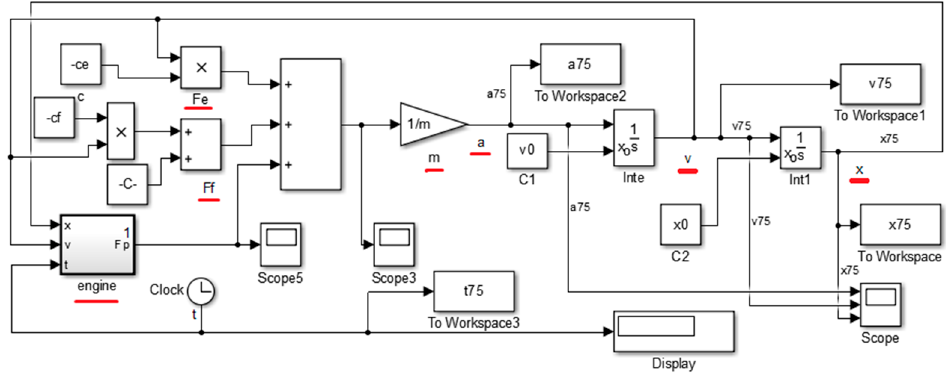
Figure 4. Simulink model of the whole CI FPLG.